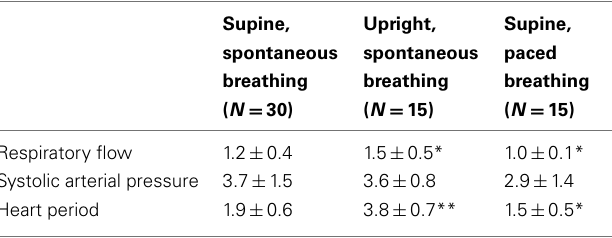
Table 2 | Optimal time delay for the selection of candidate terms to be tested in the estimation of conditional entropy.